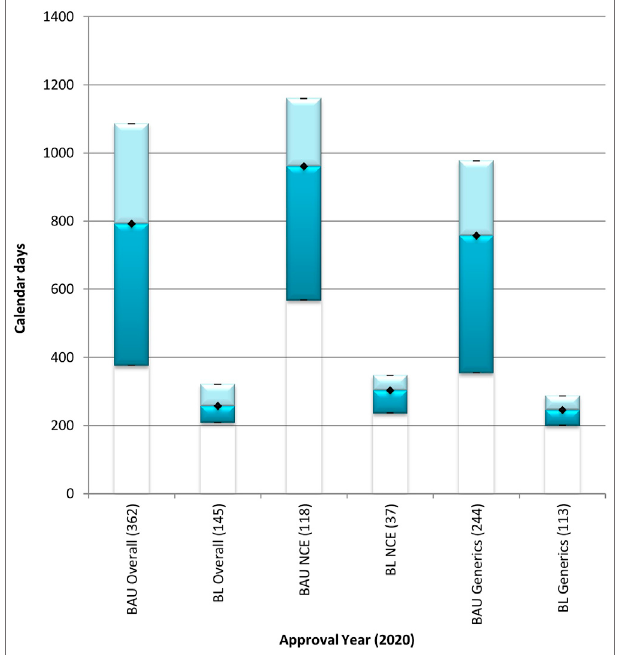
FIGURE 2 | Median overall approval times for new chemical entities and generics processed through the BAU and BL review streams in 2020. BAU, businessasusual;BL,backlog;NCE,newchemicalentity.Dataareshownfor NCEs and generics thatwereapproved in2020throughthe business as usual and the backlog process streams. (n) (cid:1) number of product applications registered in 2020. Box: 25th and 75th percentiles. Whiskers: 5th and 95th percentiles. Denotes median.